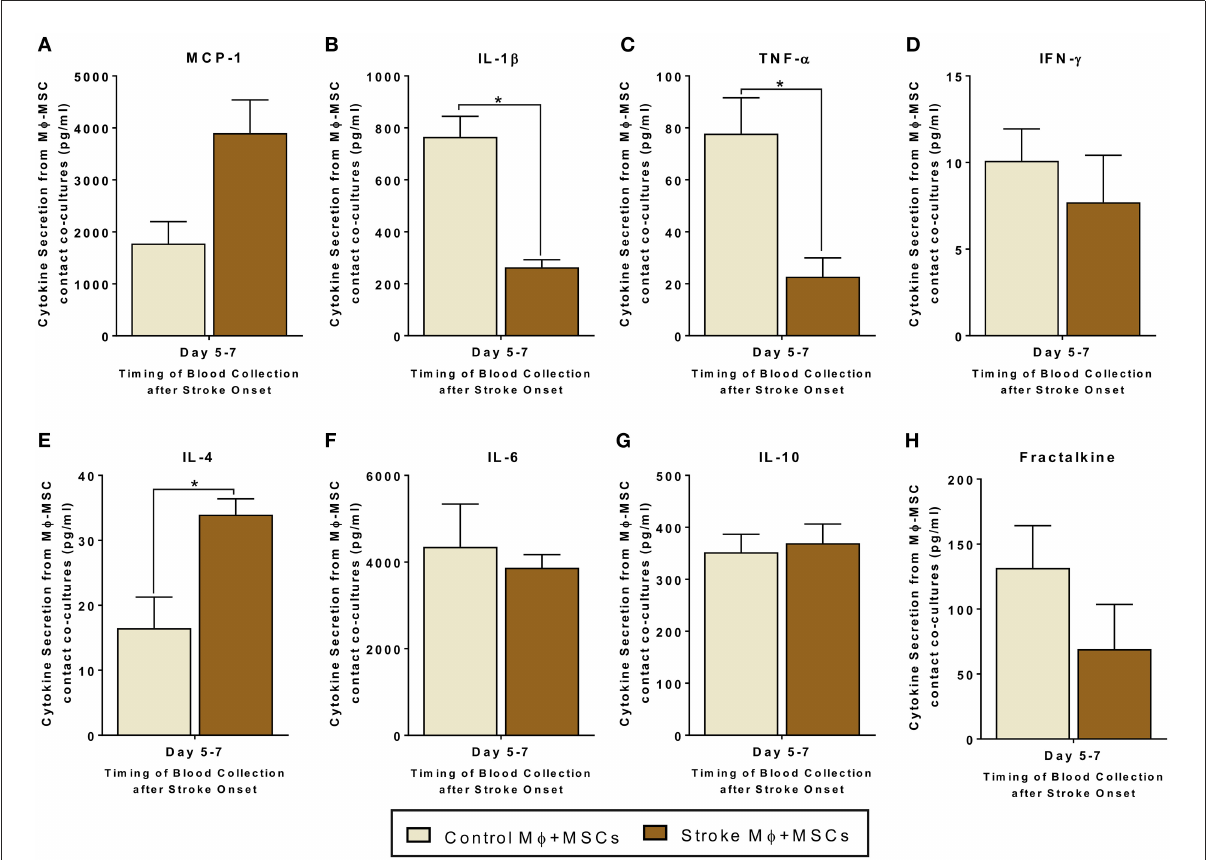
FIGURE3 Secretomes released from contact co-cultures of peripheral blood monocytes (M φ ) and human bone marrow derived mesenchymal stromal cells (MSCs). (A–H) represents secretions of MCP-1, IL-1 β , TNF- α , IFN- γ , IL-4, IL-6, IL-10, and Fractalkine. Monocytes are isolated from peripheral blood of healthy controls and stroke patients, and cultured with MSCs for 24h ( N = 5, error bars represent SEM, * p <